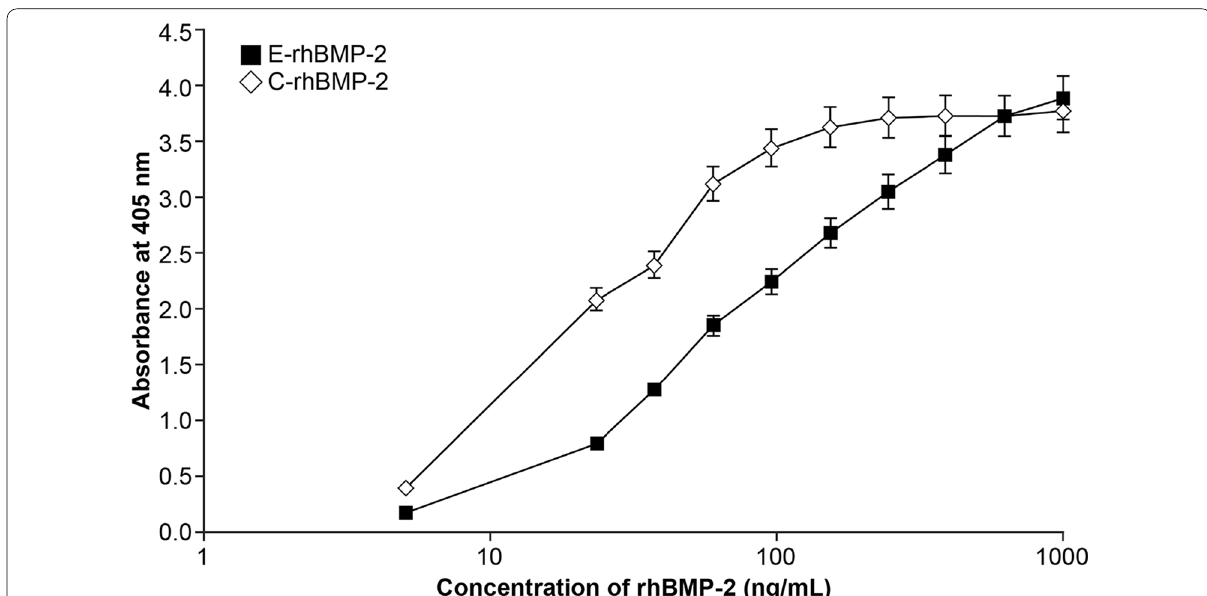
Fig. 3 Effect of E‑rhBMP‑2 and C‑rhBMP‑2 concentration on ALP activity in C2C12 cells. Optical density values were recorded at 405 nm after 72 h of culture